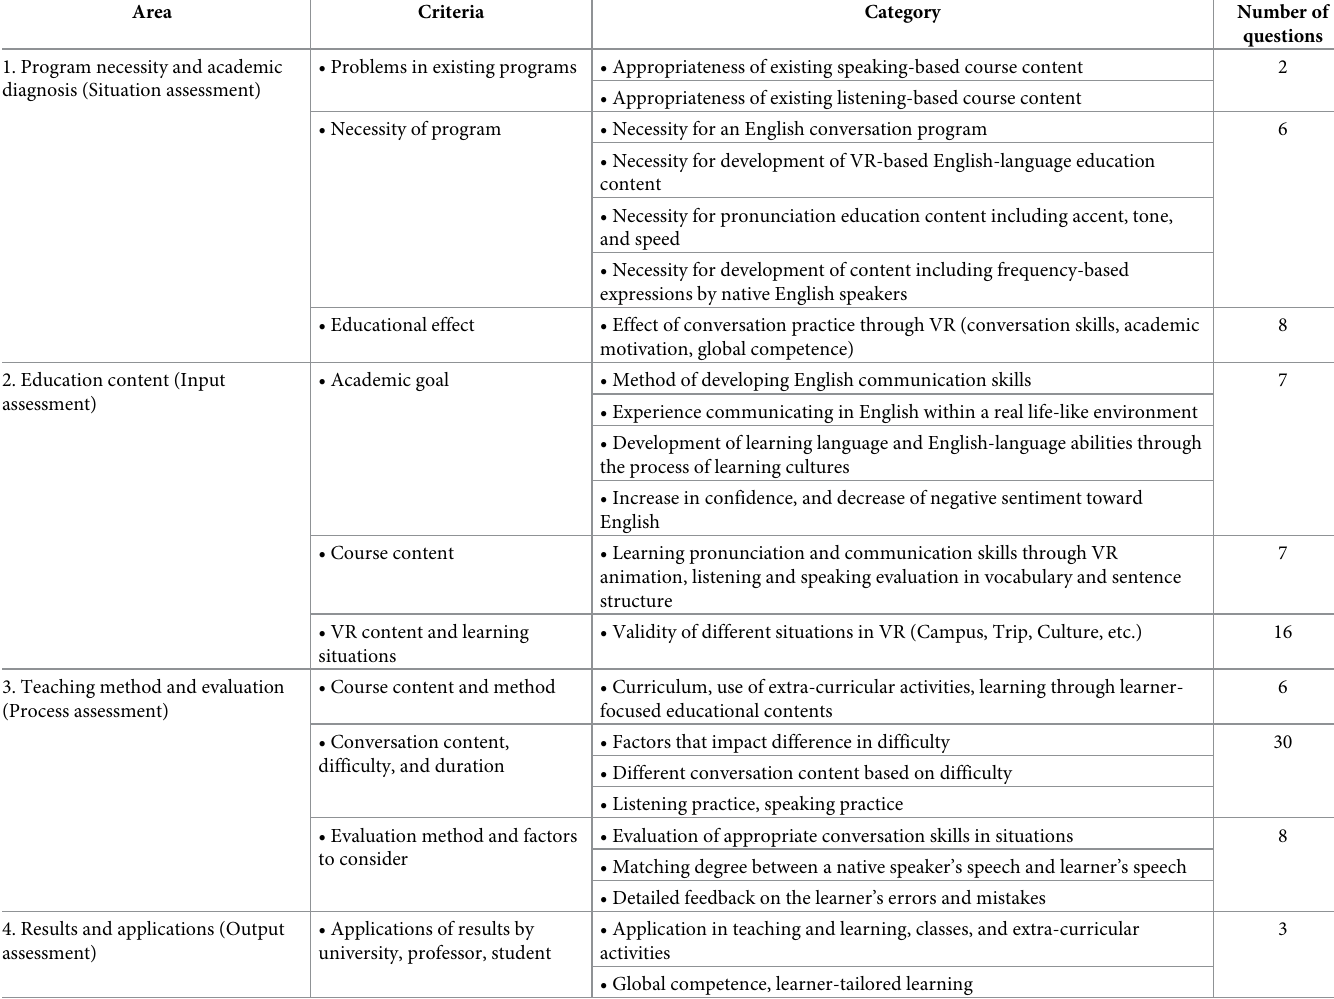
Table 3. Content of the second and third Delphi surveys with the application of CIPP model (2nd: 2019.12.16 ~2020.02.02/ 3rd: 2020.02.16 ~ 2020.02.26).